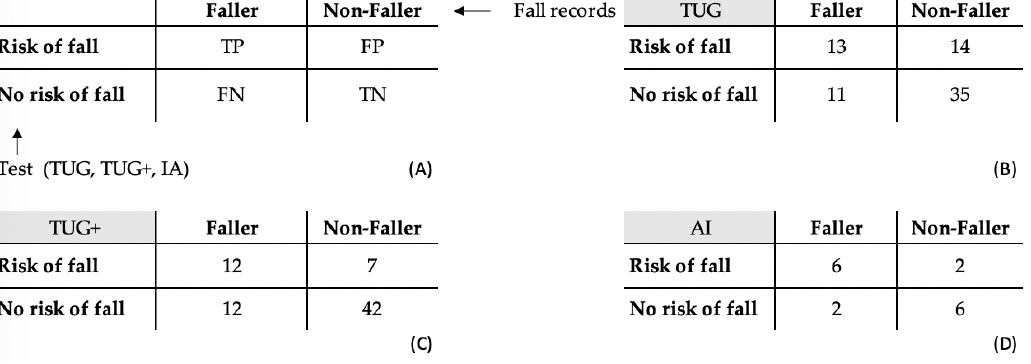
Figure 6. Confusion matrices in our study. ( A ) General definitions. TP = True Positives, FP = False Positives, FN = False Negatives, TN = True Negatives. ( B ) Results for the TUG test. ( C ) Results for the TUG+ test. ( D ) Results for the AI classification. The validation data set has 16 participants. Table 3. Characterization of the TUG and TUG+ test. The following parameters are displayed: sensitivity (Se), specificity (Sp), positive (LR + ) and negative (LR - ) likelihood ratios, positive (PPV) and negative (NPV) predictive values and accuracy (Acc). Improvements of TUG+ and AI methods with respect to TUG are emphasized in bold font.